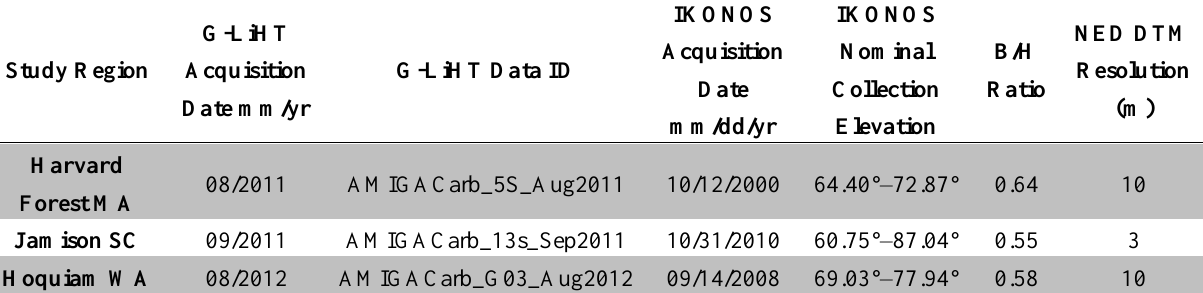
Table 1. Goddard’s airborne LiDAR Hyper-spectral and Thermal Imager (G-LiHT) and IKONOS dates of acquisition with IKONOS Geo stereo viewing geometry, base-to-height ratio and National Elevation Data (NED) digital terrain model (DTM) resolution by study